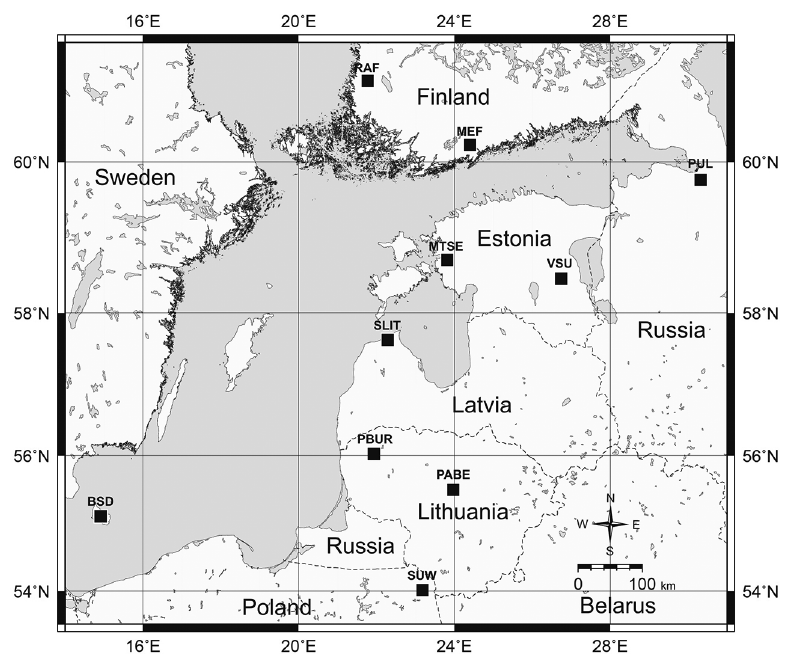
Fig. 1. Stations of the Baltic Virtual Seismic Network